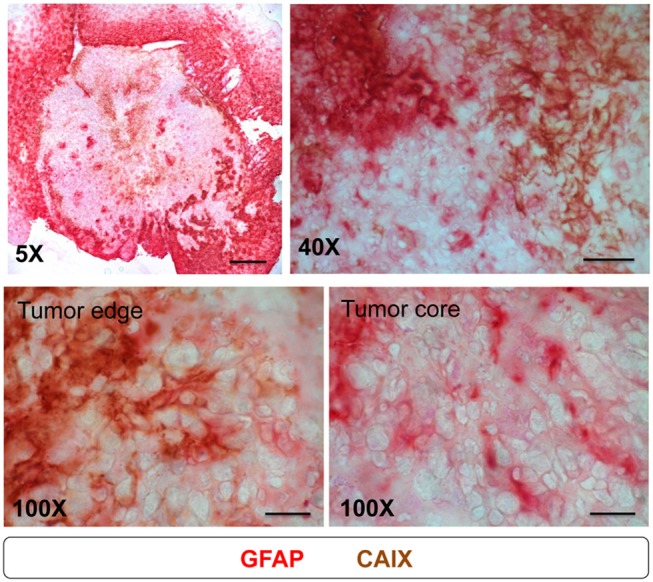
Astrocytes expressed CAIX at tumor edge, but not at tumor core. Mice were sacrificed on day 21 after I.C. inoculation of ALTS1C1 tumor. For examining the correlation of astrocyte and CAIX expression in tumors, sections were double staining by astrocyte marker GFAP (red) and hypoxia-associated marker CAIX (brown). Scale bar = 500 μm for 5X magnification, 50 μm for 40X magnification, and 20 μm for 100X magnification.